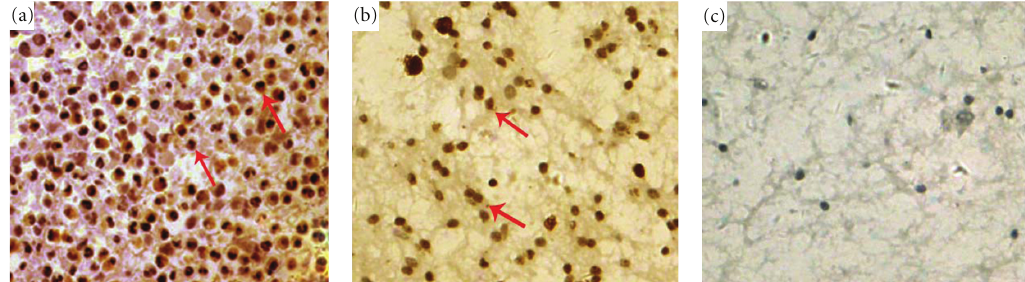
Figure 4: Immunohistochemical staining of MPG protein in tumor cells of GBM (a) and astrocytoma (b) (original magnification × 200). Staining for this antigen is described in Materials and Methods. Positive staining of MPG is seen in the nuclei of tumors cells and is more abundant in the high- (a) than the low-grade (b) tumors. Negative expression of MPG (c) was observed in nonneoplastic brain tissues.